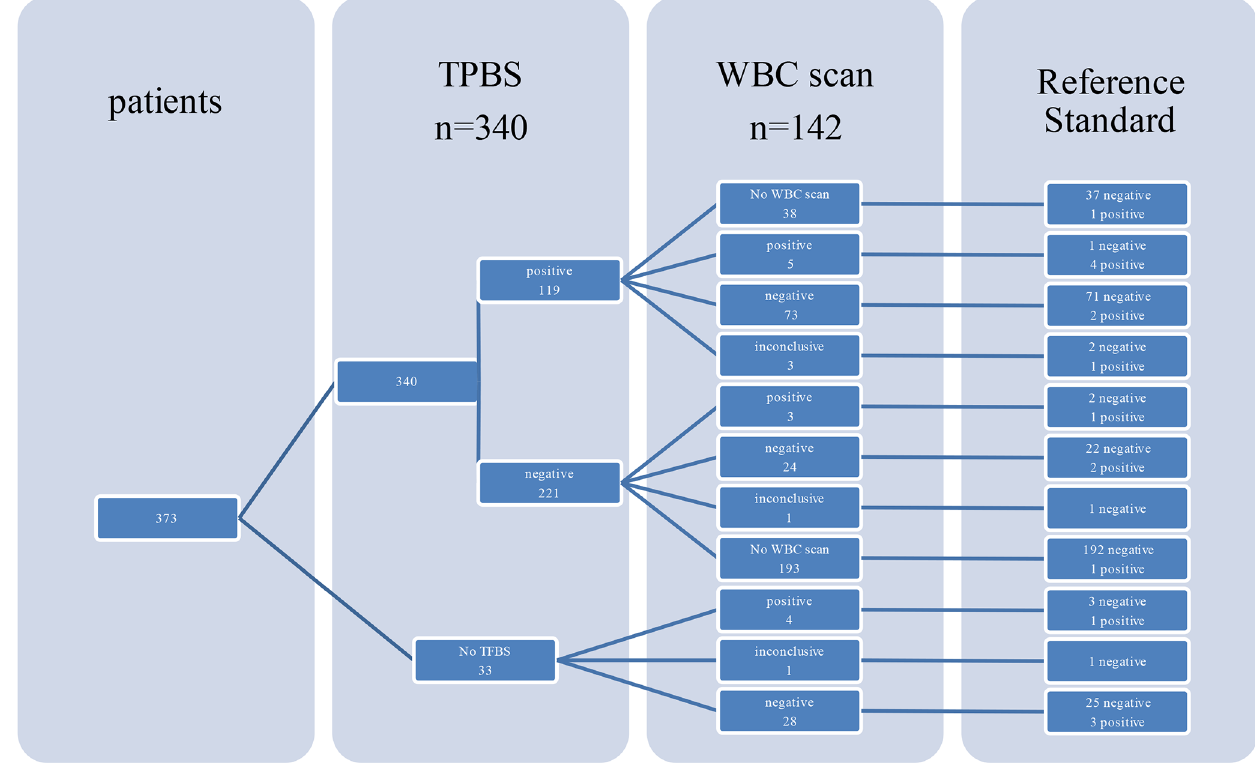
Figure 1. Flowchart made of nuclear